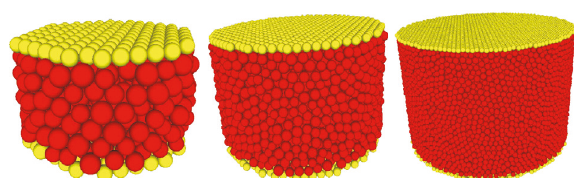
Figure 17: Cylindrical DEM geometries with three levels of refine- ment: 750, 5500, and 35000